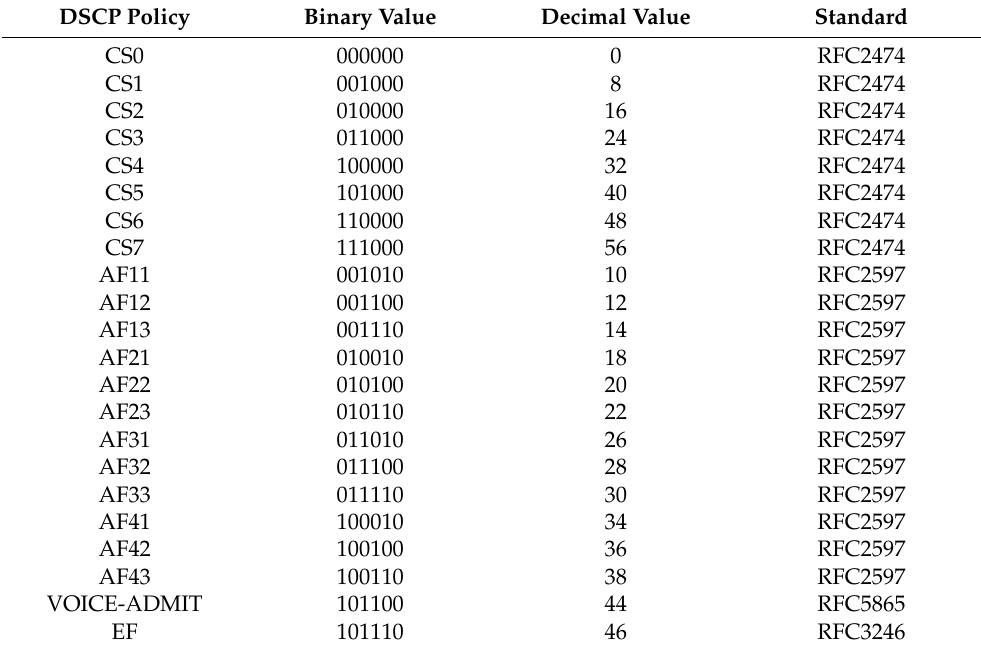
Table 1. Correspondence between numeric values and names of DSCP